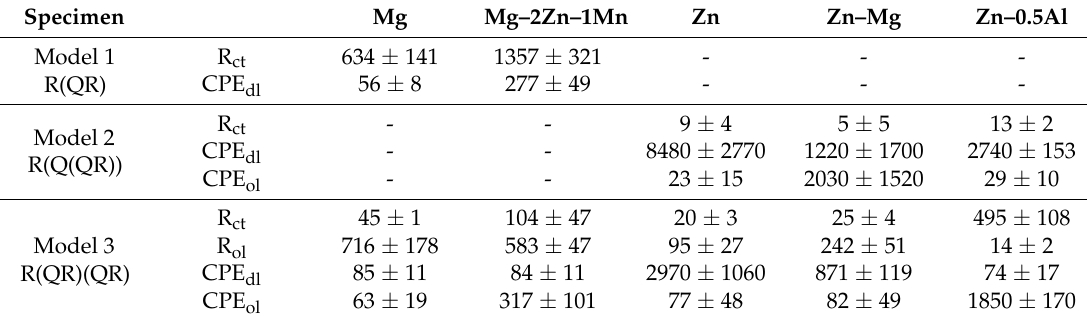
Table 4. EIS-derived parameters (R in Ω cm 2 and CPE in µ